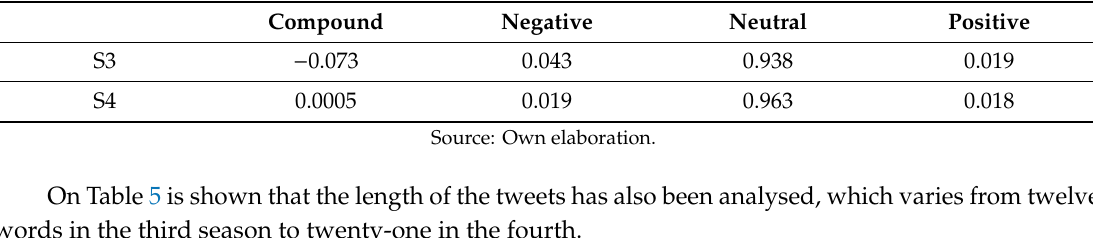
Table 4. Valence Aware Dictionary and Sentiment Reasoner (VADER) analysis.